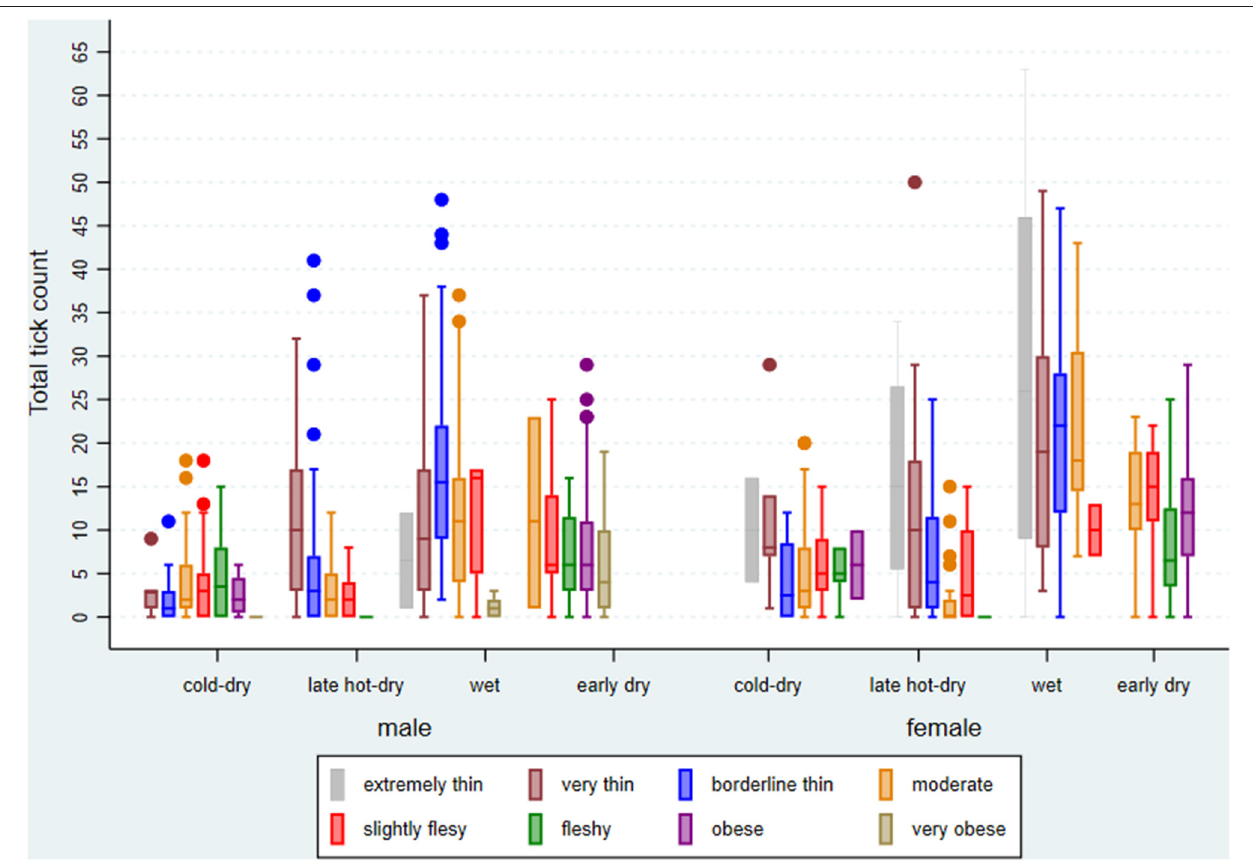
FIGURE 4 | Box plot of summary statistics for tick counts by season of the year, sex, and body condition score (BCS), excluding missing BCS, of cattle investigated at Ngamiland abattoir during the study.